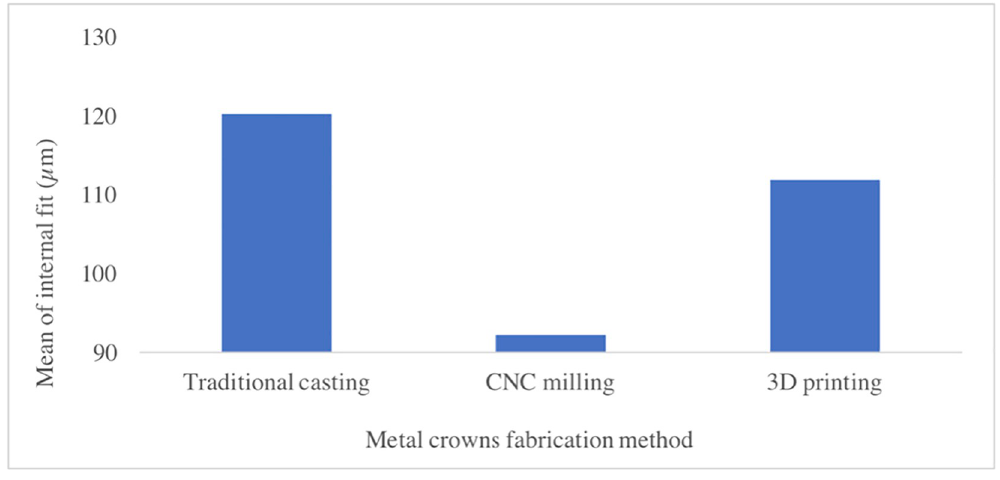
Fig 7. Average values for each